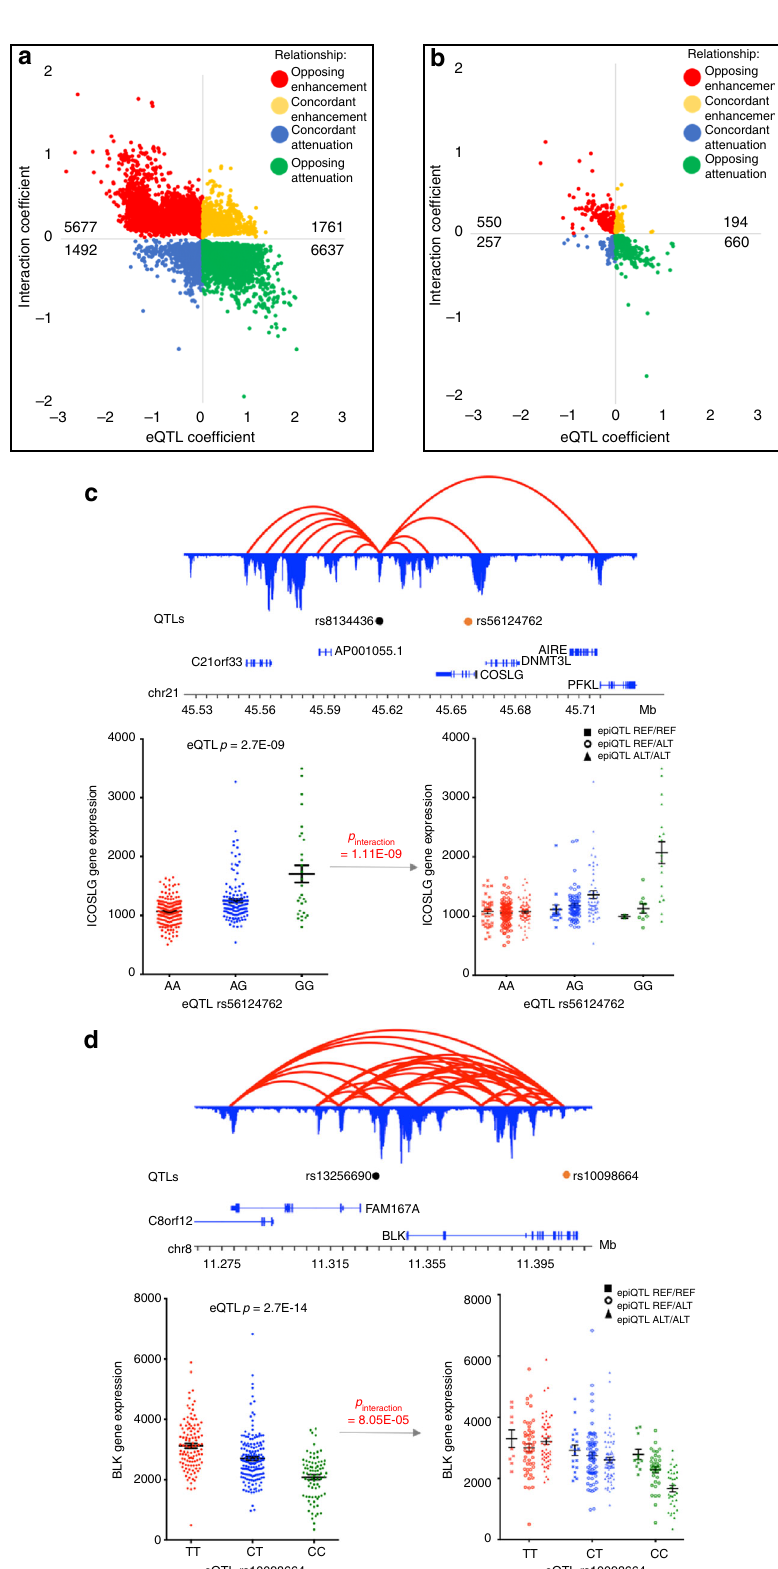
scores <1%. We also used strand cross-correlation to calculate the normalized strand coef fi cient (NSC) and relative strand coef fi cient (RSC), and repeated experiments with NSC < 1.05 and RSC< 0.8. Raw FASTQ reads were quality fi l- tered and trimmed for Illumina adapters using Trimmomatic v0.35 55 . Reads aligning to Poly-A, Poly-C, ribosomal, mitochondrial, or Phi-X sequences were